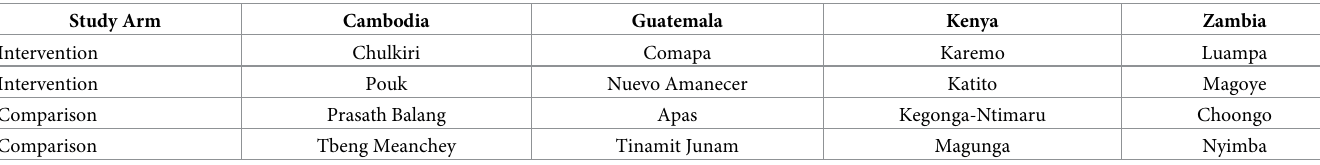
Table 1. Selected study sites in each country—Districts/sub